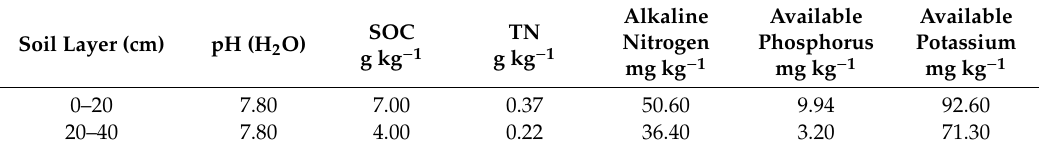
Table 1. Basic characteristics of the soil before the experiment in 1985.